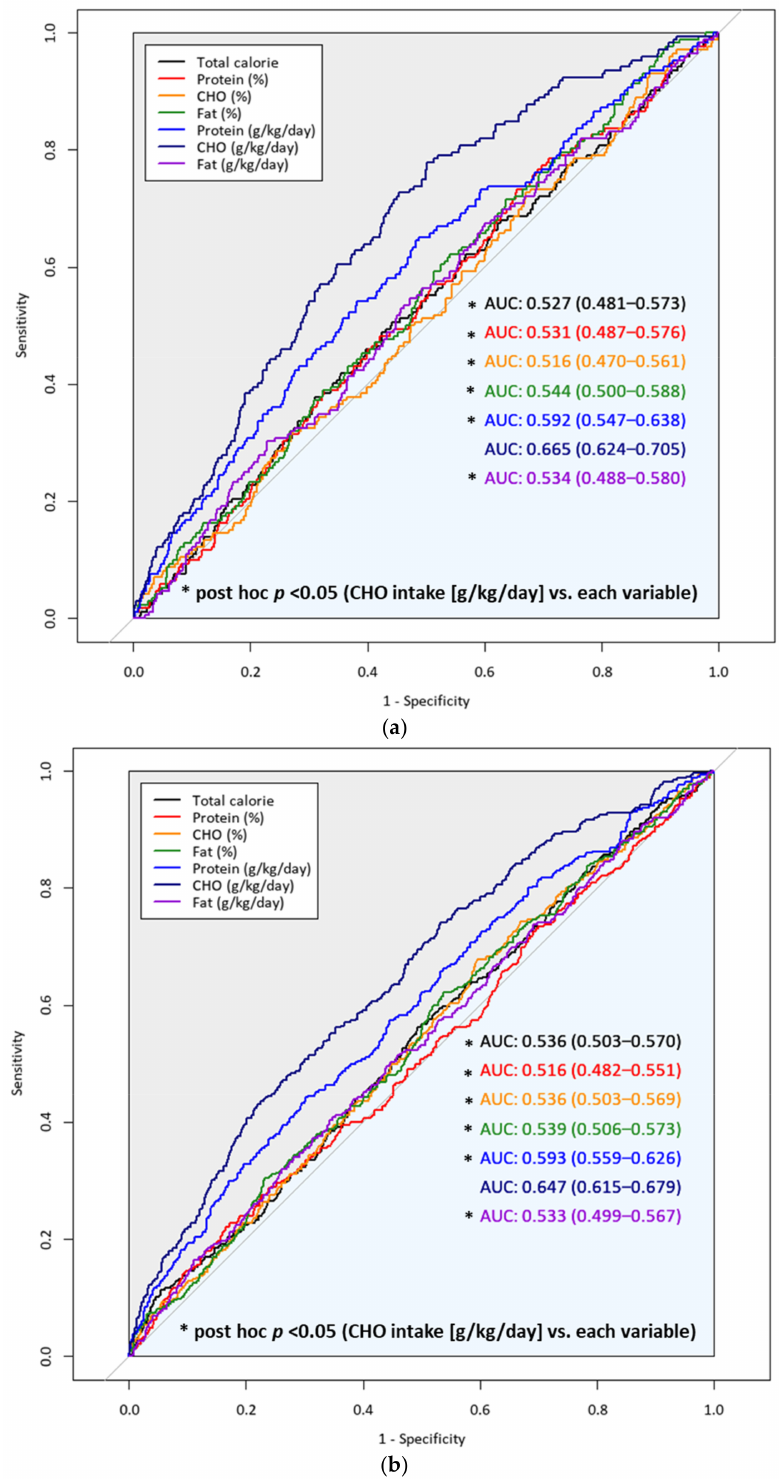
Figure 5. Comparison of predictive power for sarcopenic obesity of each pattern of macronutrient intake in ( a ) men and ( b ) women. Abbreviations: CHO, carbohydrate; AUC, area under the receiver- operating